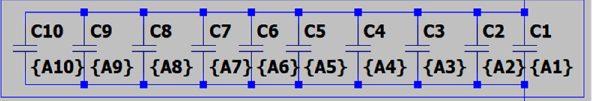
Figure 7. Capacitor-cluster as “Node” and capacitor within as “Transaction”.